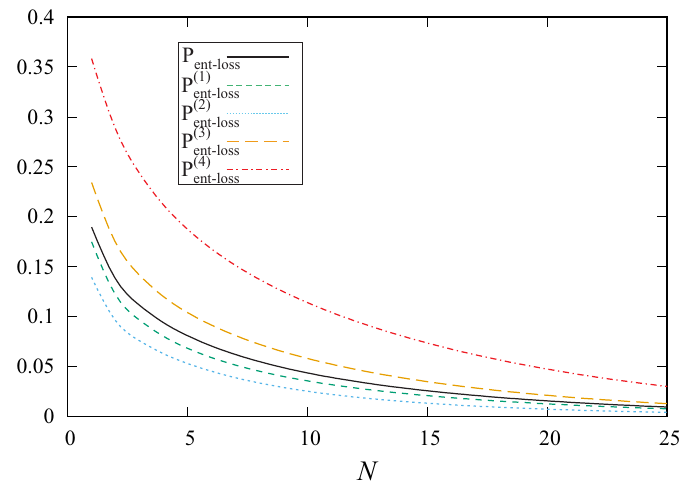
( r ) , r = 1, R , on the buffer capacity N . ent − loss